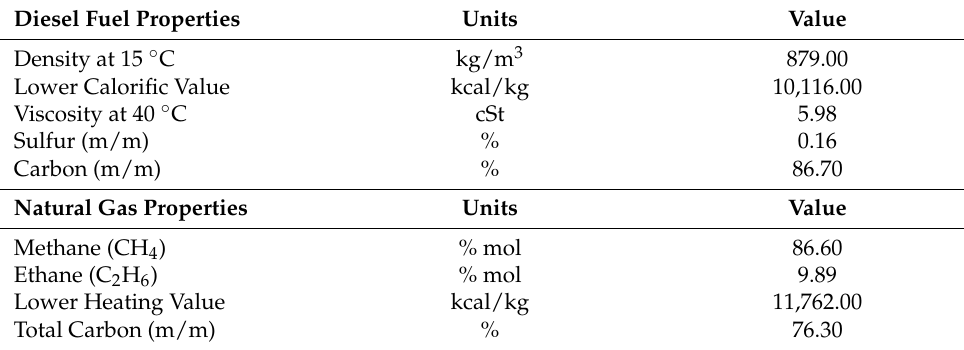
Table 2. Diesel fuel and natural gas properties.